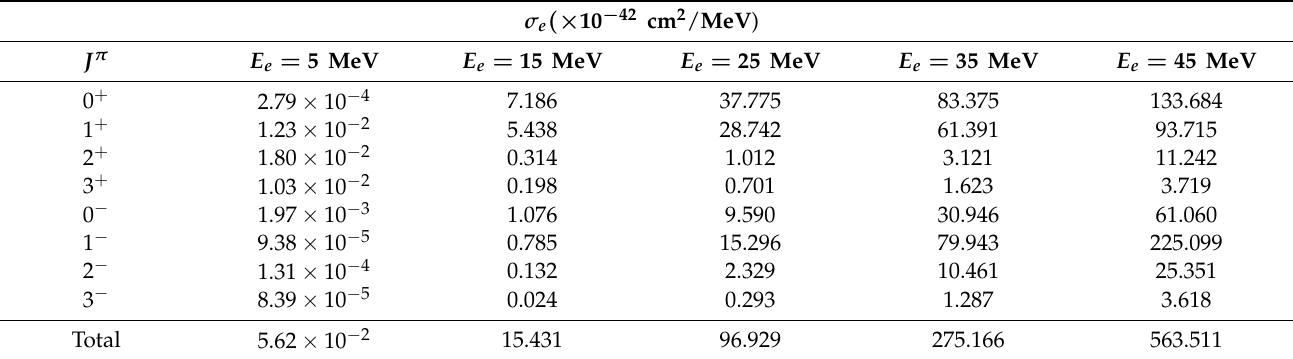
Table 4. Partial e − -capture cross-sections (in 10 − 42 MeV − 1 cm 2 ) on the 90 Zr isotope for different values of incident electron energy E e